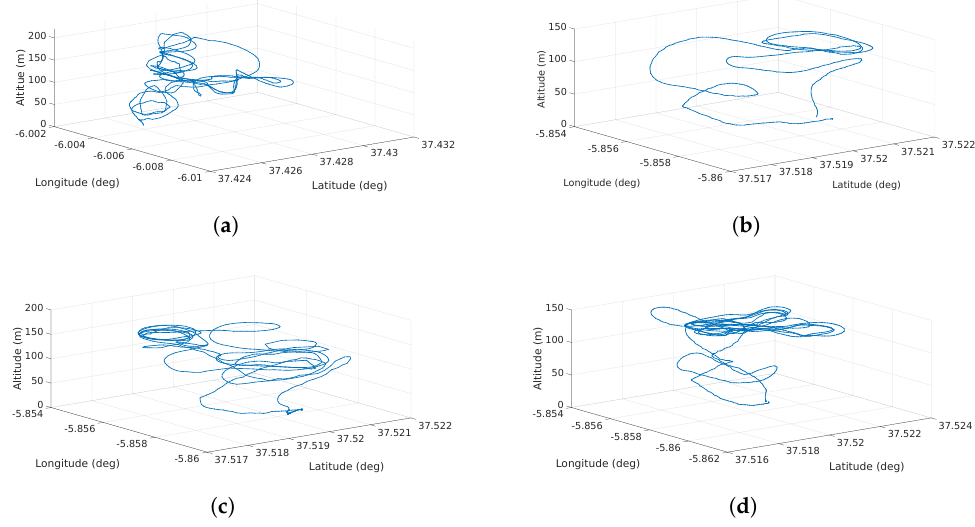
Figure 14. UAS Trajectory for validation of the wind information system. ( a ) shows a medium altitude with few spirals; ( b ) shows the shortest flight; ( c ) shows a flight with spirals performed at an altitude of 120 m; and ( d ) shows a flight with wide spirals at an altitude of 120 m.